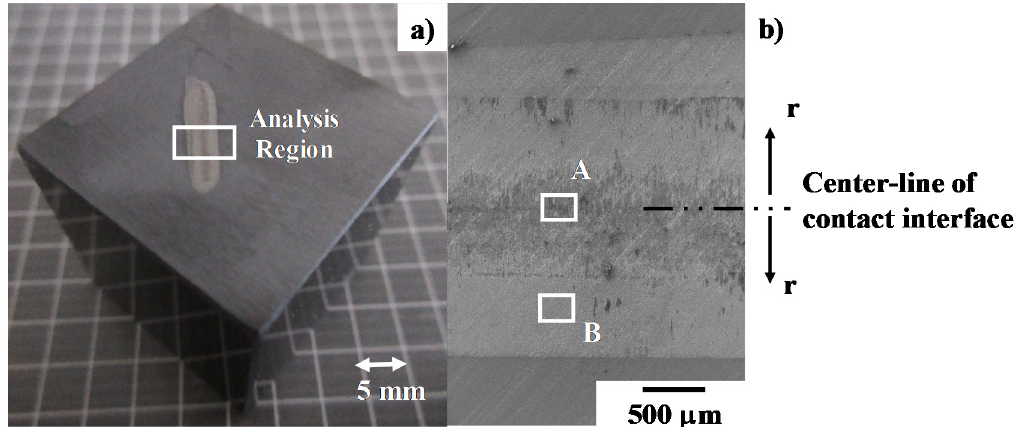
Figure 8. Optical microscopy and SEM analyses on the contact interface conditions of SiC-coated SiC punch after dry cold forging up to r = 70% for 10 shots. ( a ) Optical microscopy image on the SiC coating after cold forging test, and ( b ) SEM images on the black and white zones.